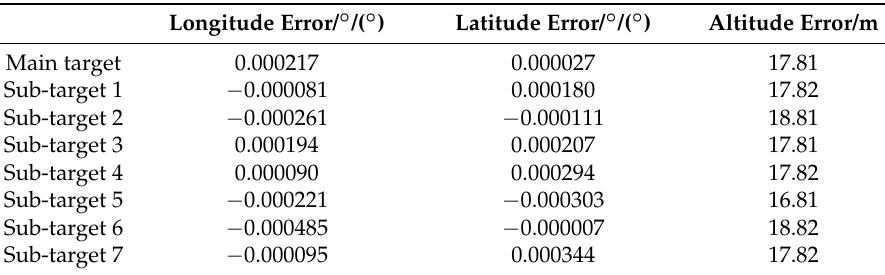
Table 4. Geo-location error of each target in a single